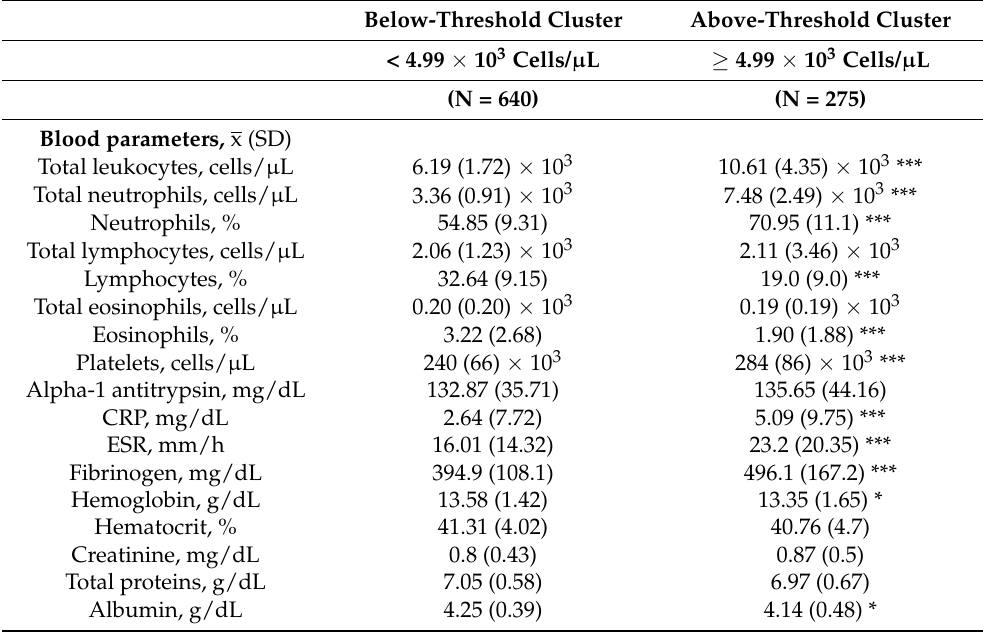
Table 6. Inflammatory and nutritional parameters in the two clusters of patients, excluding those with COPD.